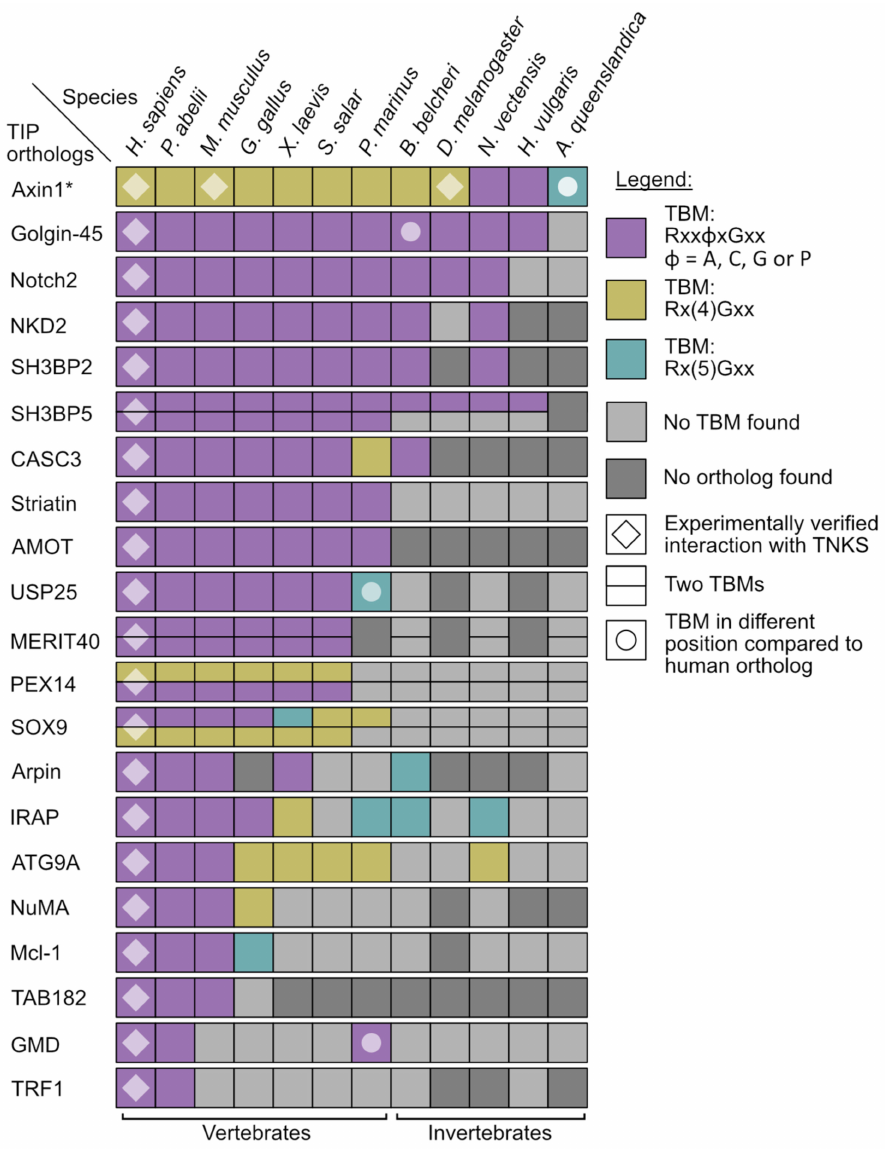
Figure 6. Identification of corresponding tankyrase binding motifs in orthologs of confirmed inter- action partners. Orthologs of 21 TNKS interaction partners (TIPs) were examined for presence or absence of possible TBM sequences. Three configurations Rxx[ACGP]xGxx, Rx(4)Gxx and Rx(5)Gxx were considered as TBM. TBMs were only considered if the motif aligned with the TBM in the human ortholog in a multiple sequence alignment, although in some cases also TBMs that did not align but were found in nearby positions are shown (see legend). * The non-canonical second motif from Axin1 was not included in this